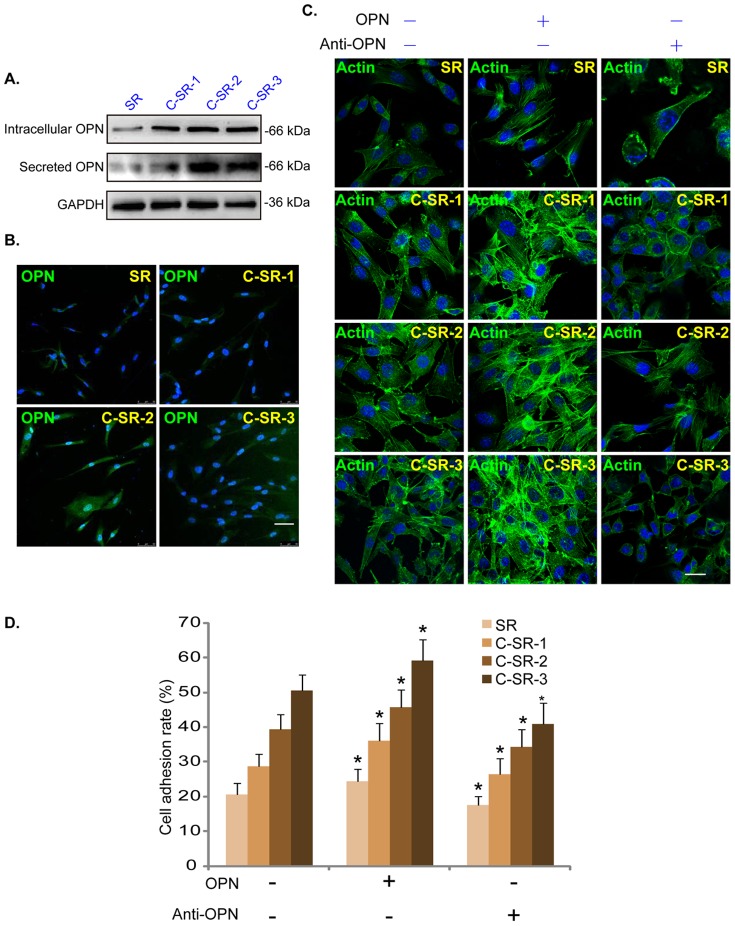
OPN acts as an important protein to promote cell adhesion on the surface of C-SR.(A) Western blots results show the expression level of OPN secreted from dermal fibroblasts cultured on SR or C-SR coated 6-well plate (48 hours). Note that OPN was up-regulated and secreted from dermal fibroblasts cultured on C-SRs. (B) Immuno-fluorescence images show that the expression level of OPN in dermal fibroblasts cultured on C-SR coated 6-well plate was increased (48 hours). (C) FITC-labeled actin tracer results demonstrate that exogenously-added purified OPN (0.5 µg/ml) enhanced dermal fibroblasts adhesion and proliferation. On the other hand, the monoclonal antibody against OPN inhibited dermal fibroblasts adhesion and proliferation on the surface of C-SRs (48 hours). (D) Cell adhesion on different substrates. OPN promoted fibroblasts adhesion, and monoclonal antibody against OPN significantly inhibited cell adhesion. However, the difference was not statistically significant when the substrate in group (OPN− Anti-OPN−) was respectively compared to the substrate in group (OPN+ Anti-OPN−) or group (OPN− Anti-OPN+) (p>0.05). The difference was significant between the substrates in group (OPN+ Anti-OPN−) and group (OPN− Anti-OPN+) (*p<0.05). These experiments were repeated three times, similar results were obtained each time (Fig. 4A, Fig. 4B and Fig. 4C). Bar = 20 µm. The cell adhesion test was performed six times, the data are expressed as mean ± SD (Fig. 4D).